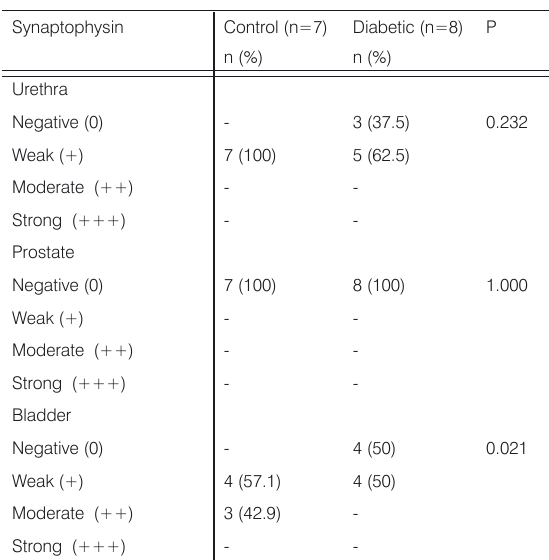
Table 2. Distribution of study groups according to staining intensity regarding synaptophysin positive neural structures present in the lower urinary tract of